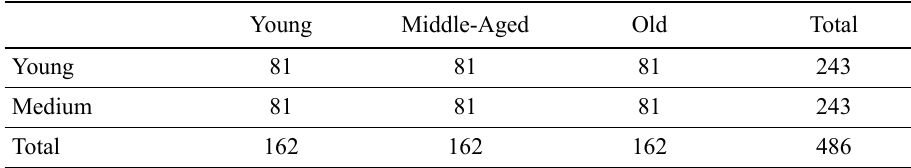
Table 2. Balanced